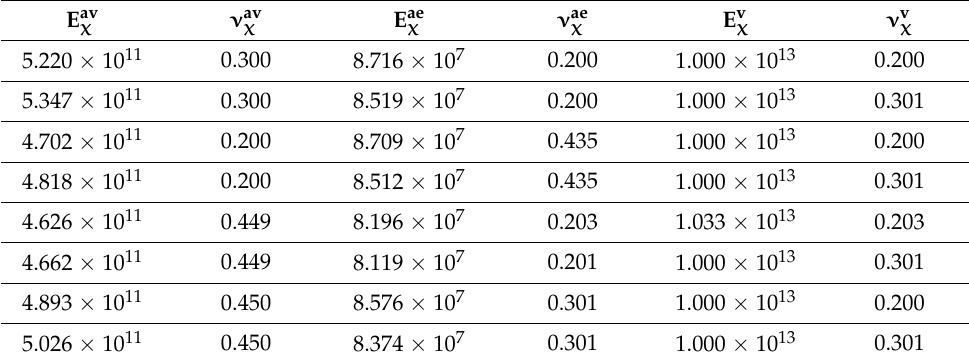
Table A1. Inverse identification results for the case n = 2 ( I 1 = [ 0.005,0.25 ] and I 2 = [ 0.25,0.5 ] ).